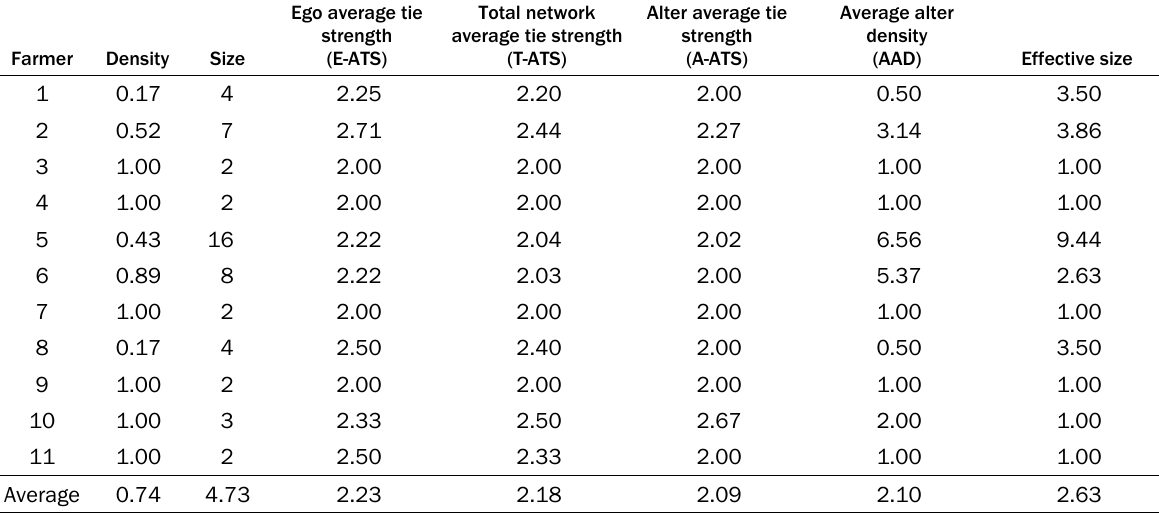
Table 2. Advice Network Statistics